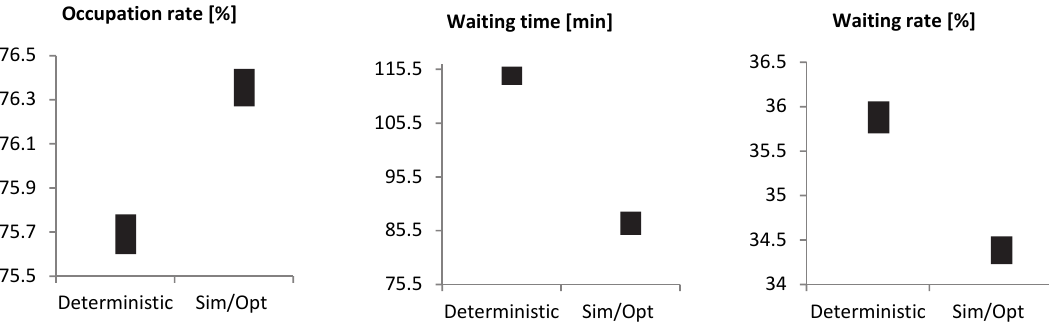
Fig. 4. Confidence intervals of 95% for the indicators using the Tukey